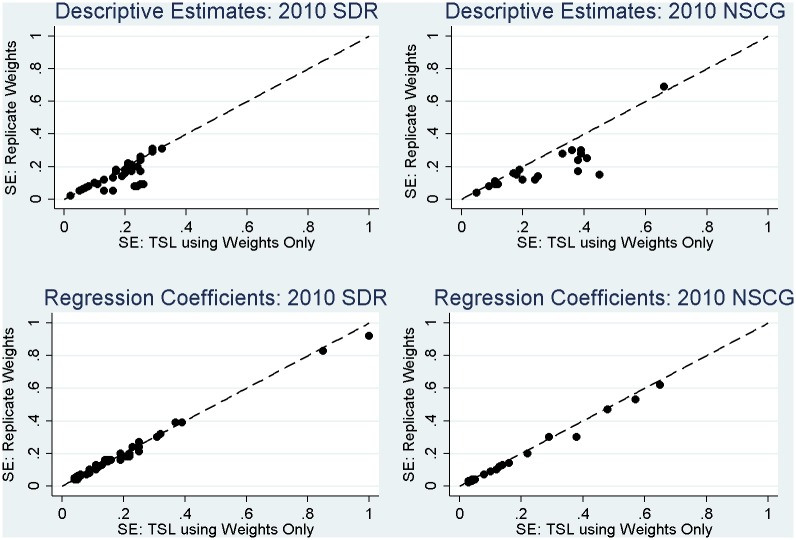
Correspondence between estimated standard errors (SE) for 2010 SDR and 2010 NSCG estimates based on the replicate weights, which fully account for the complex sampling features, and linearized (TSL) standard errors based on the final survey weights only (including a dashed 45-degree line representing perfect correspondence).